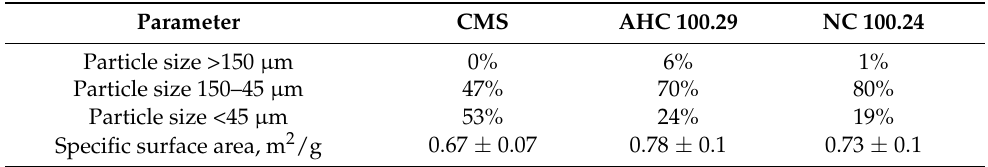
Table 2. Physical properties of iron powders—CMS: iron particles collected from industrial dust filter; AHC100.29: water-atomized iron-based powder; NC100.24: sponge-iron powder.